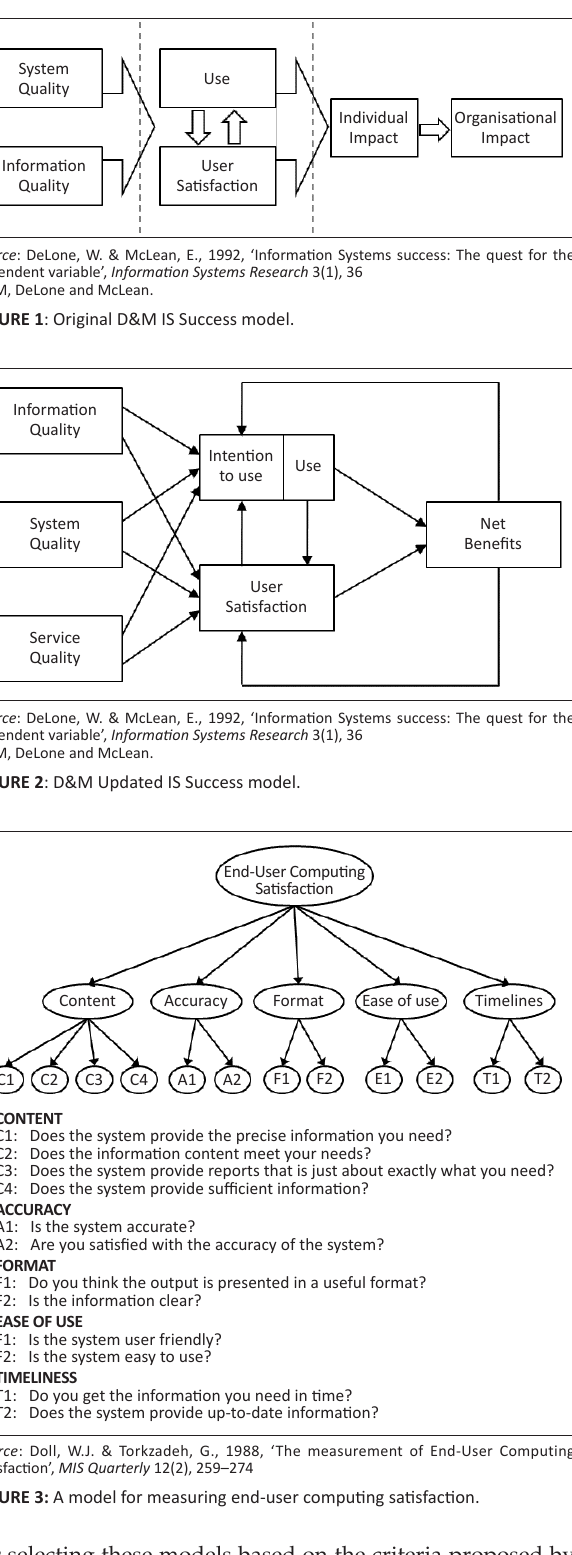
FIGURE 3: A model for measuring end-user computing